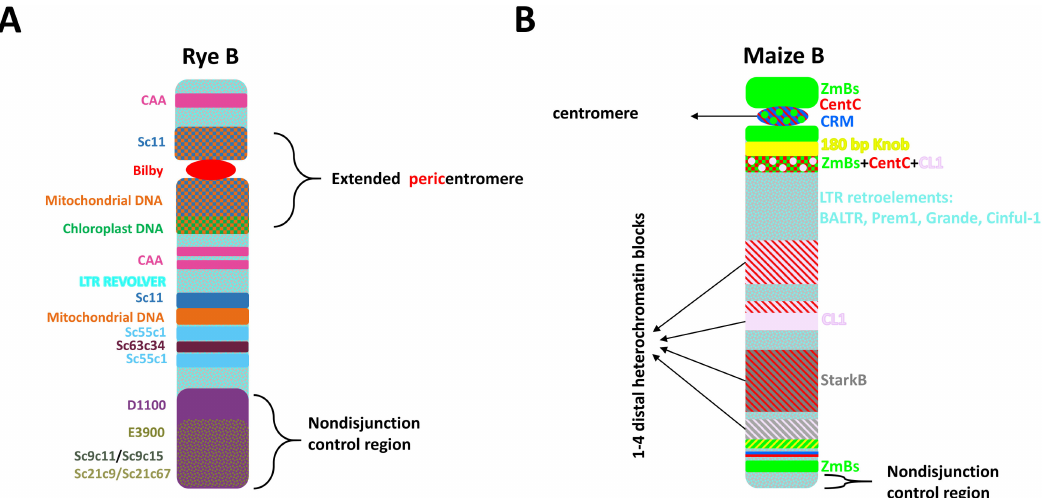
Figure 1. Model for the distribution of ( A ) rye and ( B ) maize B chromosome-enriched sequences. In both rye Bs and maize Bs only the very terminal region of B long arm is required for non-disjunction control